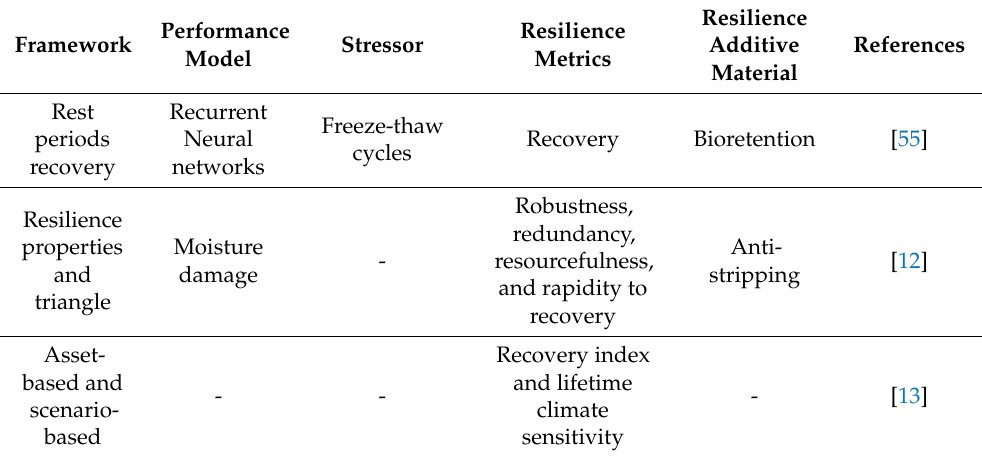
Resilience framework, performance model and metrics, stressors, and resilience additive